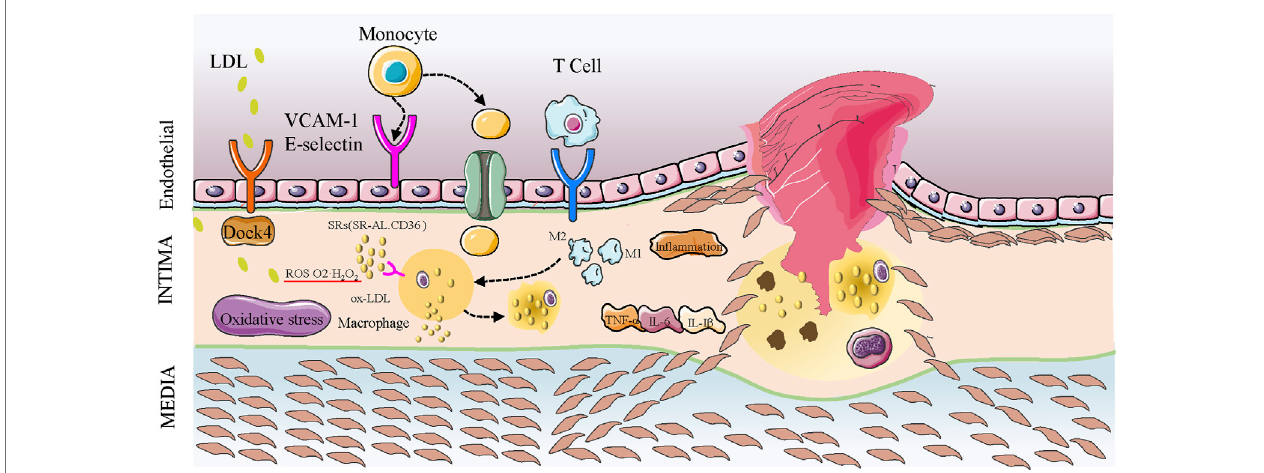
FIGURE 1 | Development of atherosclerotic plaques. LDL enters the arterial intima via endothelial cells expressing SR-B1 receptors in combination with DOCK4 action.LDLparticlesareoxidizedtoox-LDL,andthemonocytesenteringtheintimaaretransformedintomacrophagesthatphagocytizeox-LDLmediatedbysurfaceSR (SR-A1, CD36). They also phagocytize other cholesterols in the intima to form foam cells. Macrophages are polarized into M1 and M2 forms. M1 macrophages release pro-in fl ammatory factors such as IL-6 to promote plaque progression, and oxidative stress promotes in fl ammatory factors. SMCs enter the intima to form fi brous caps, and oxidative stress and in fl ammation promote apoptosis and cell death in the plaque, leading to the accumulation of lipid and lipid cores. The continuous in fl ammation and oxidative stress causes the lipid nuclei to enlarge, the fi brous cap dilutes and ruptures, and platelets accumulate to form thrombi.